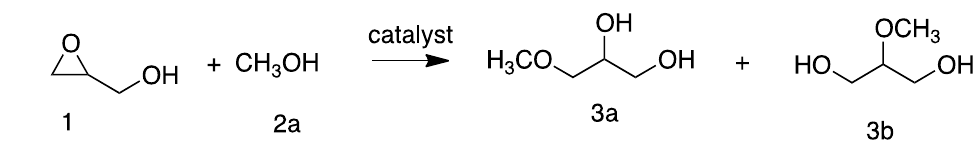
Figure 1. Influence of catalyst loading and reaction temperature in glycidol ( 1 ) conversion and product yields in the reaction of glycidol and methanol catalyzed with Dowex 50WX2.